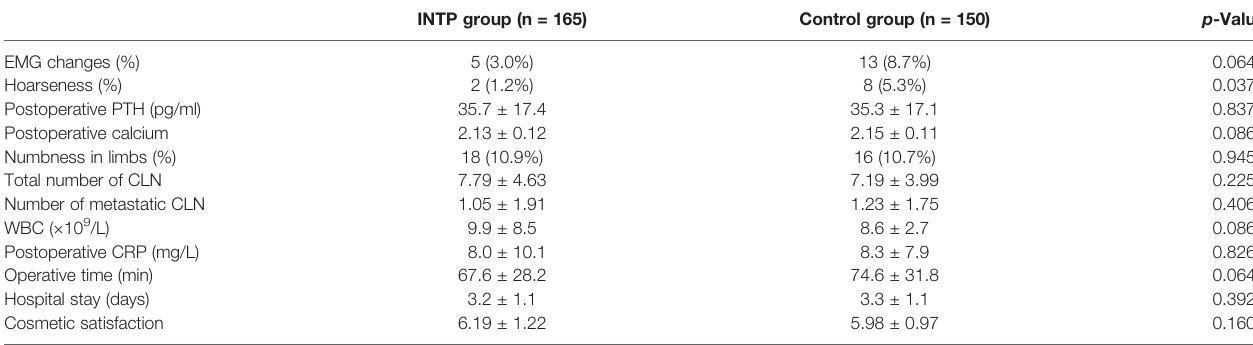
TABLE 4 | Effective assessment of INTP in open thyroidectomy.